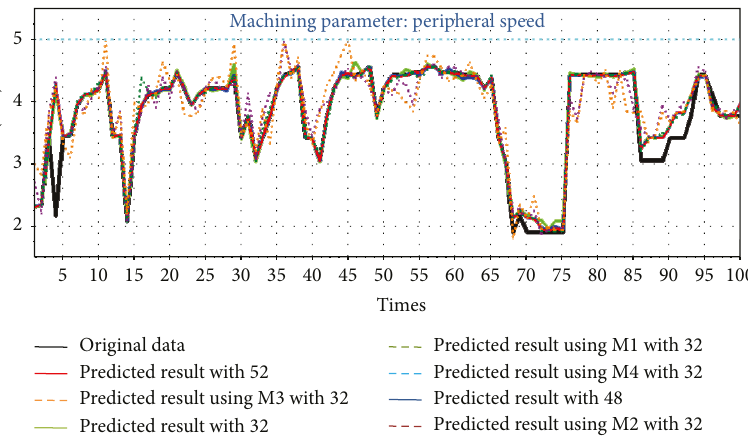
Figure 16: Predicted results of peripheral speed of grinding wheel.